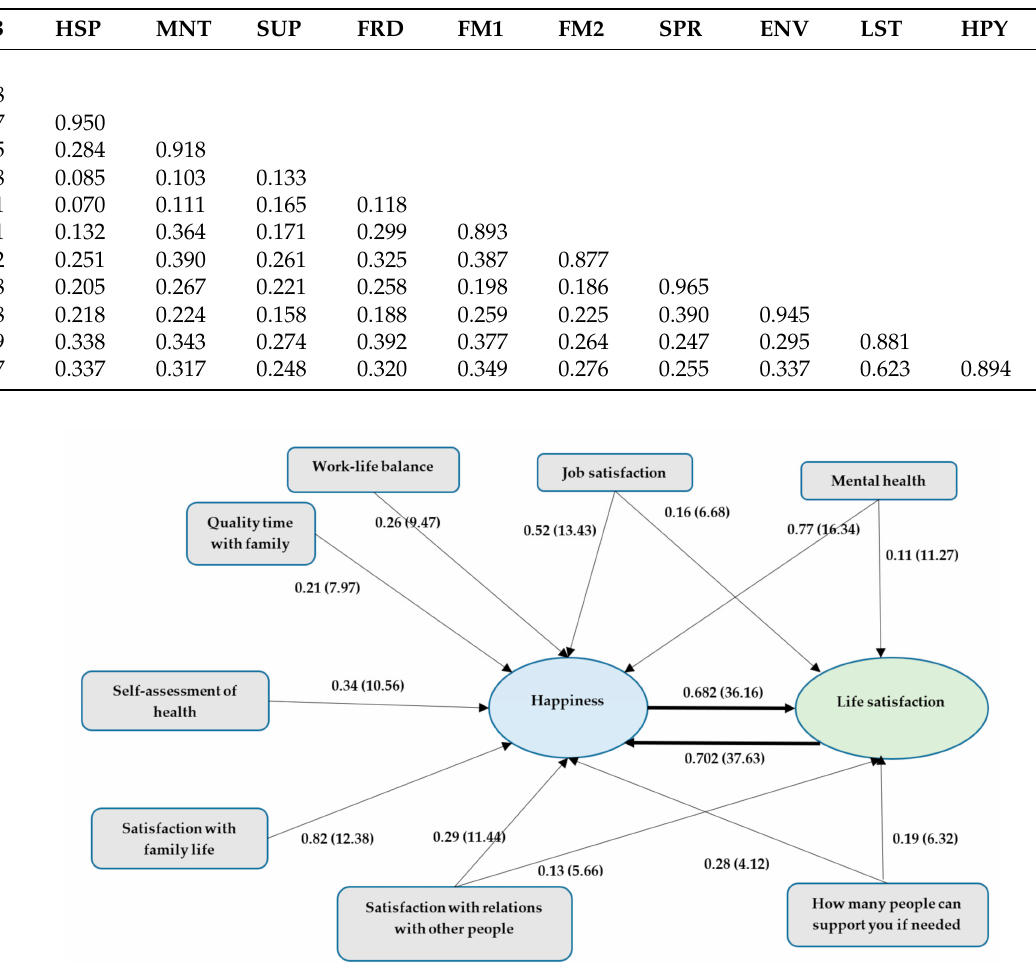
Table 4. The covariance matrix of variables in the model.